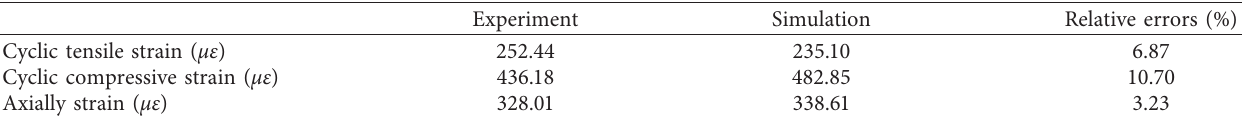
Figure 4: Stress distribution of PE pipe in the verification model. (a) 0 ms. (b) 5.599ms. (c) 7.799ms. (d) 9.799ms. (e) 11.799ms. (f) 12.999ms. (g) 17.399ms. (h) 40.0ms. Table 5: Comparison with experimental